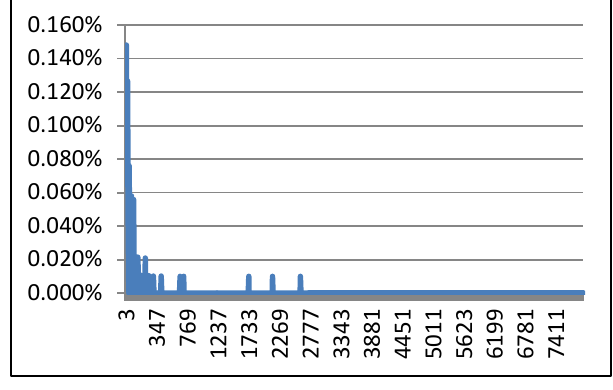
Fig. 3. Verification park k = 1, sequence length fixed, the error percentage vertical axis: error percentage horizontal axis: the value of From Fig. 3, we can see when , the error percentage is extremely low. If , the error percentage goes to